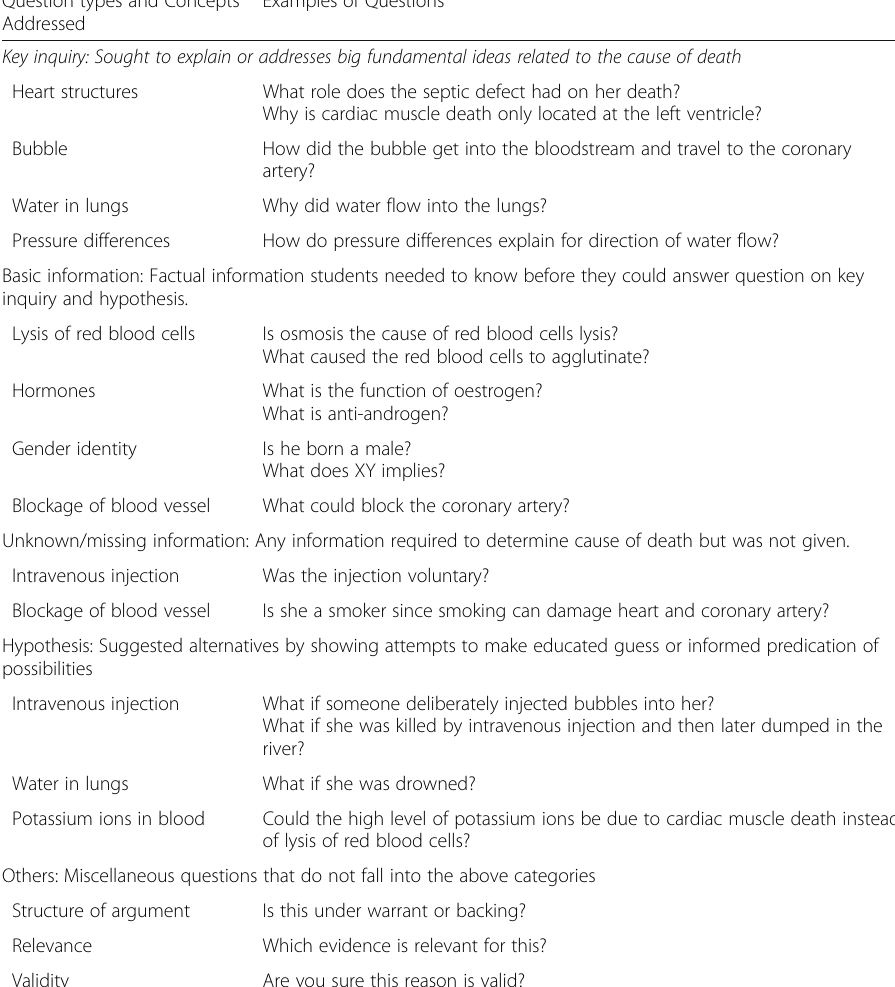
Table 5 Types of questions (adapted from Chin & Osborne, 2010) asked by students (oral and written forms)